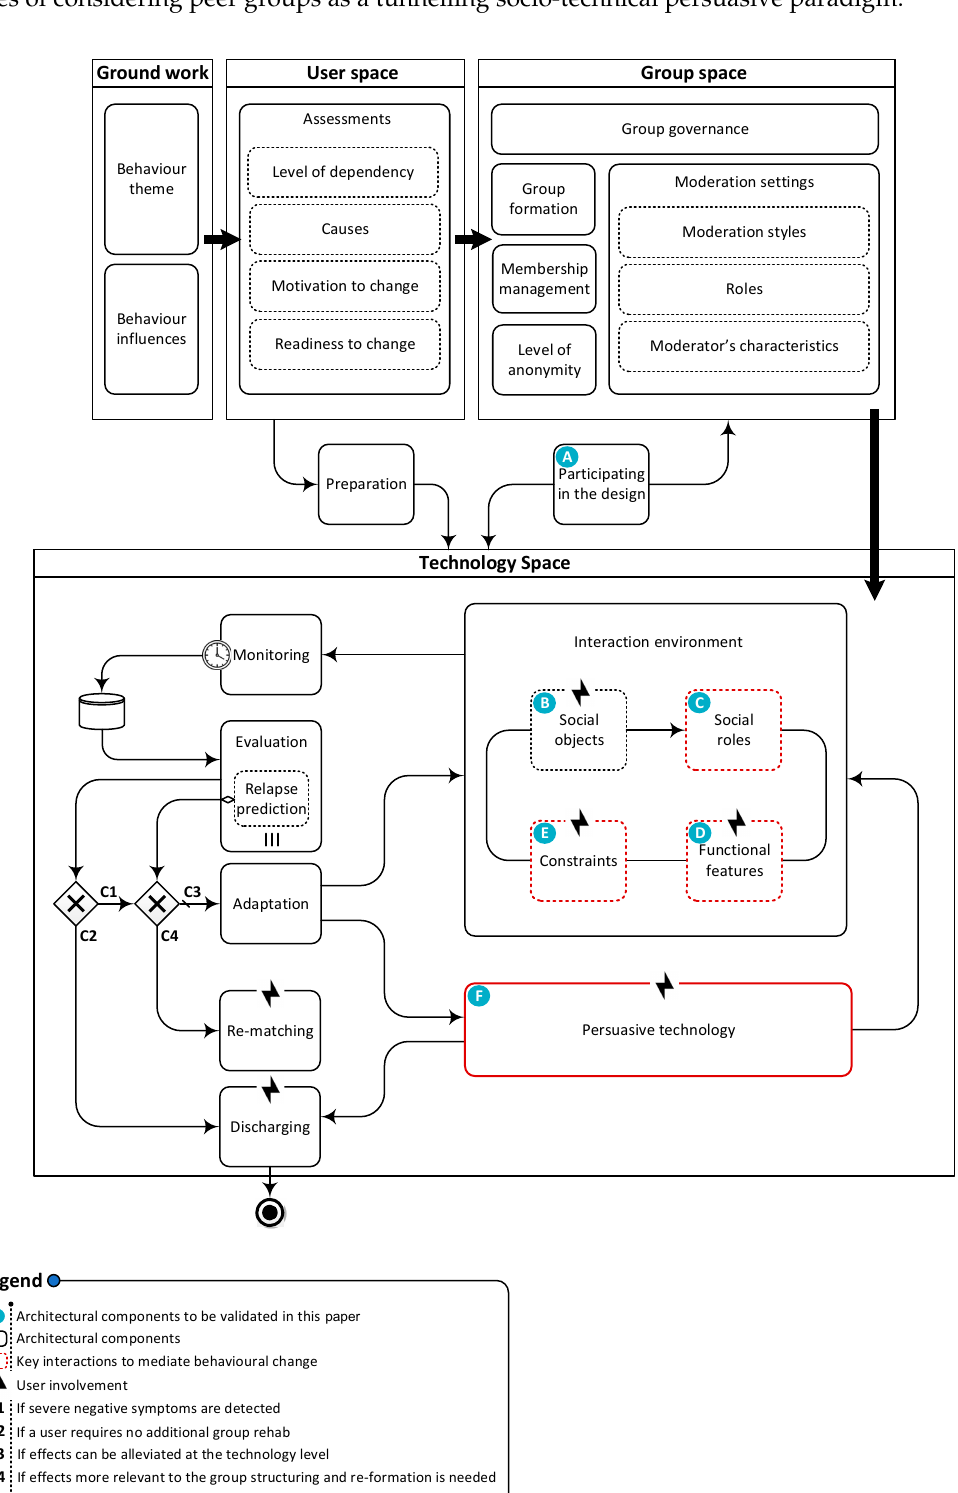
Figure 4. The COPE.er method reference architecture.